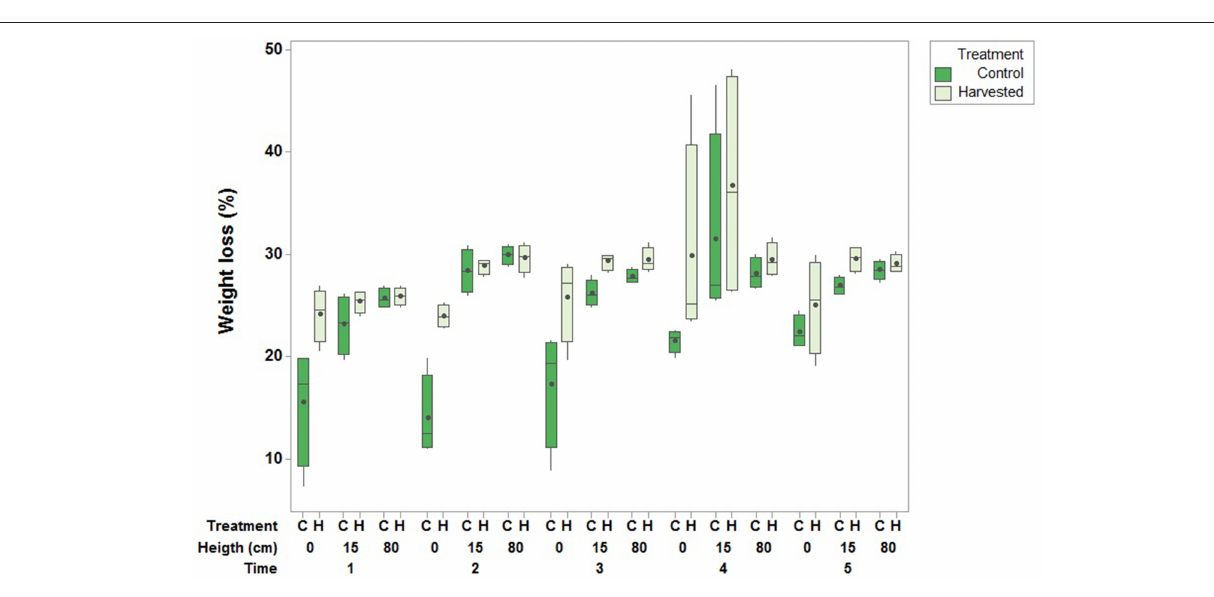
FIGURE 7 | Effect of seagrass removal treatment on % loss of gypsum clod cards (central lines are medians, boxes interquartile ranges and the dots are means) over a 24-h exposure period. Boxplots are based on one measurement per plot ( N = 4 per treatment) with three heights (0, 15, and 80cm from the sediment) and five measurement times [February (1), March (2), August (3) and December (4) 2015 and June 2016